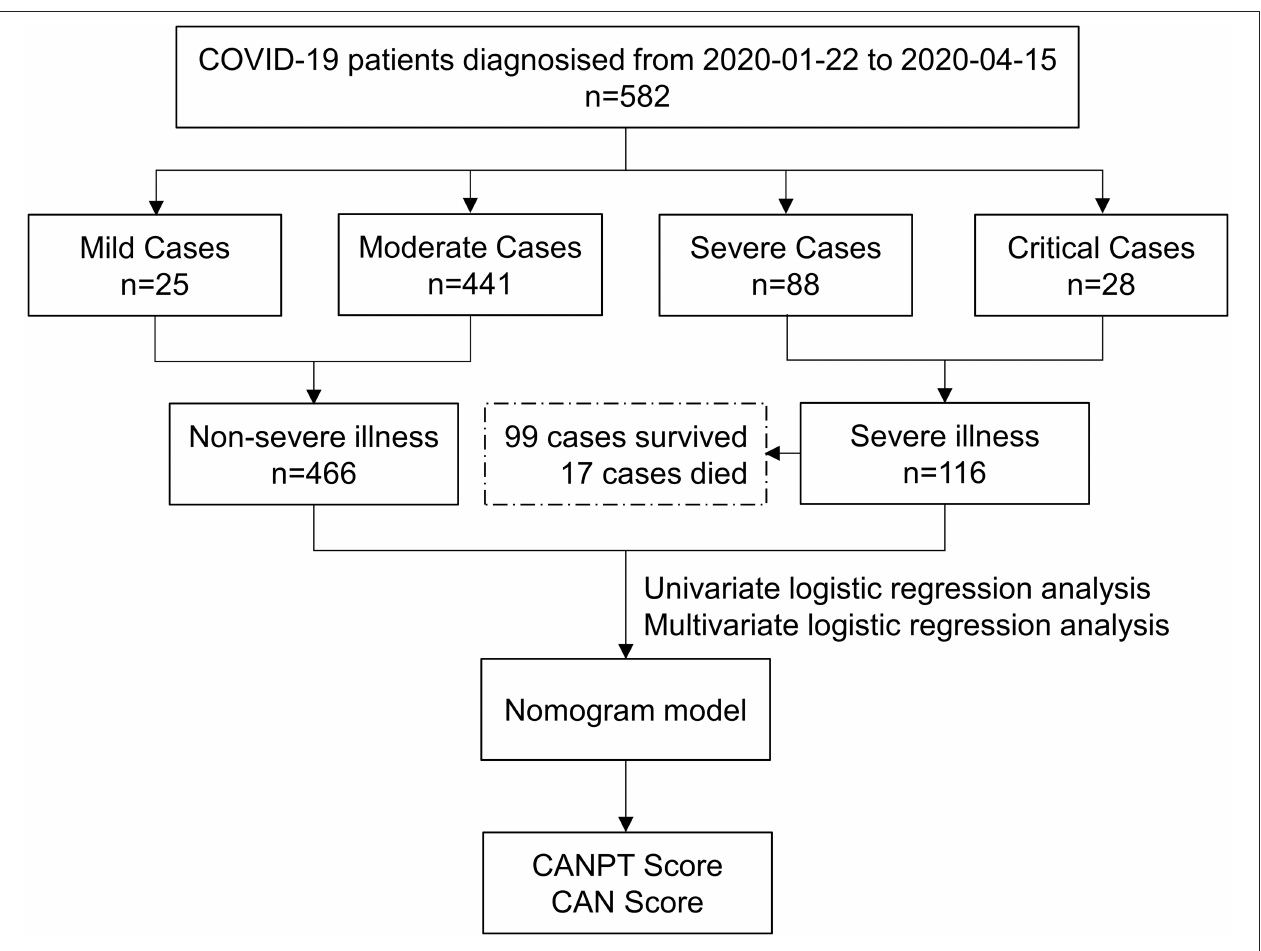
FIGURE 1 | Flow chart of the study.